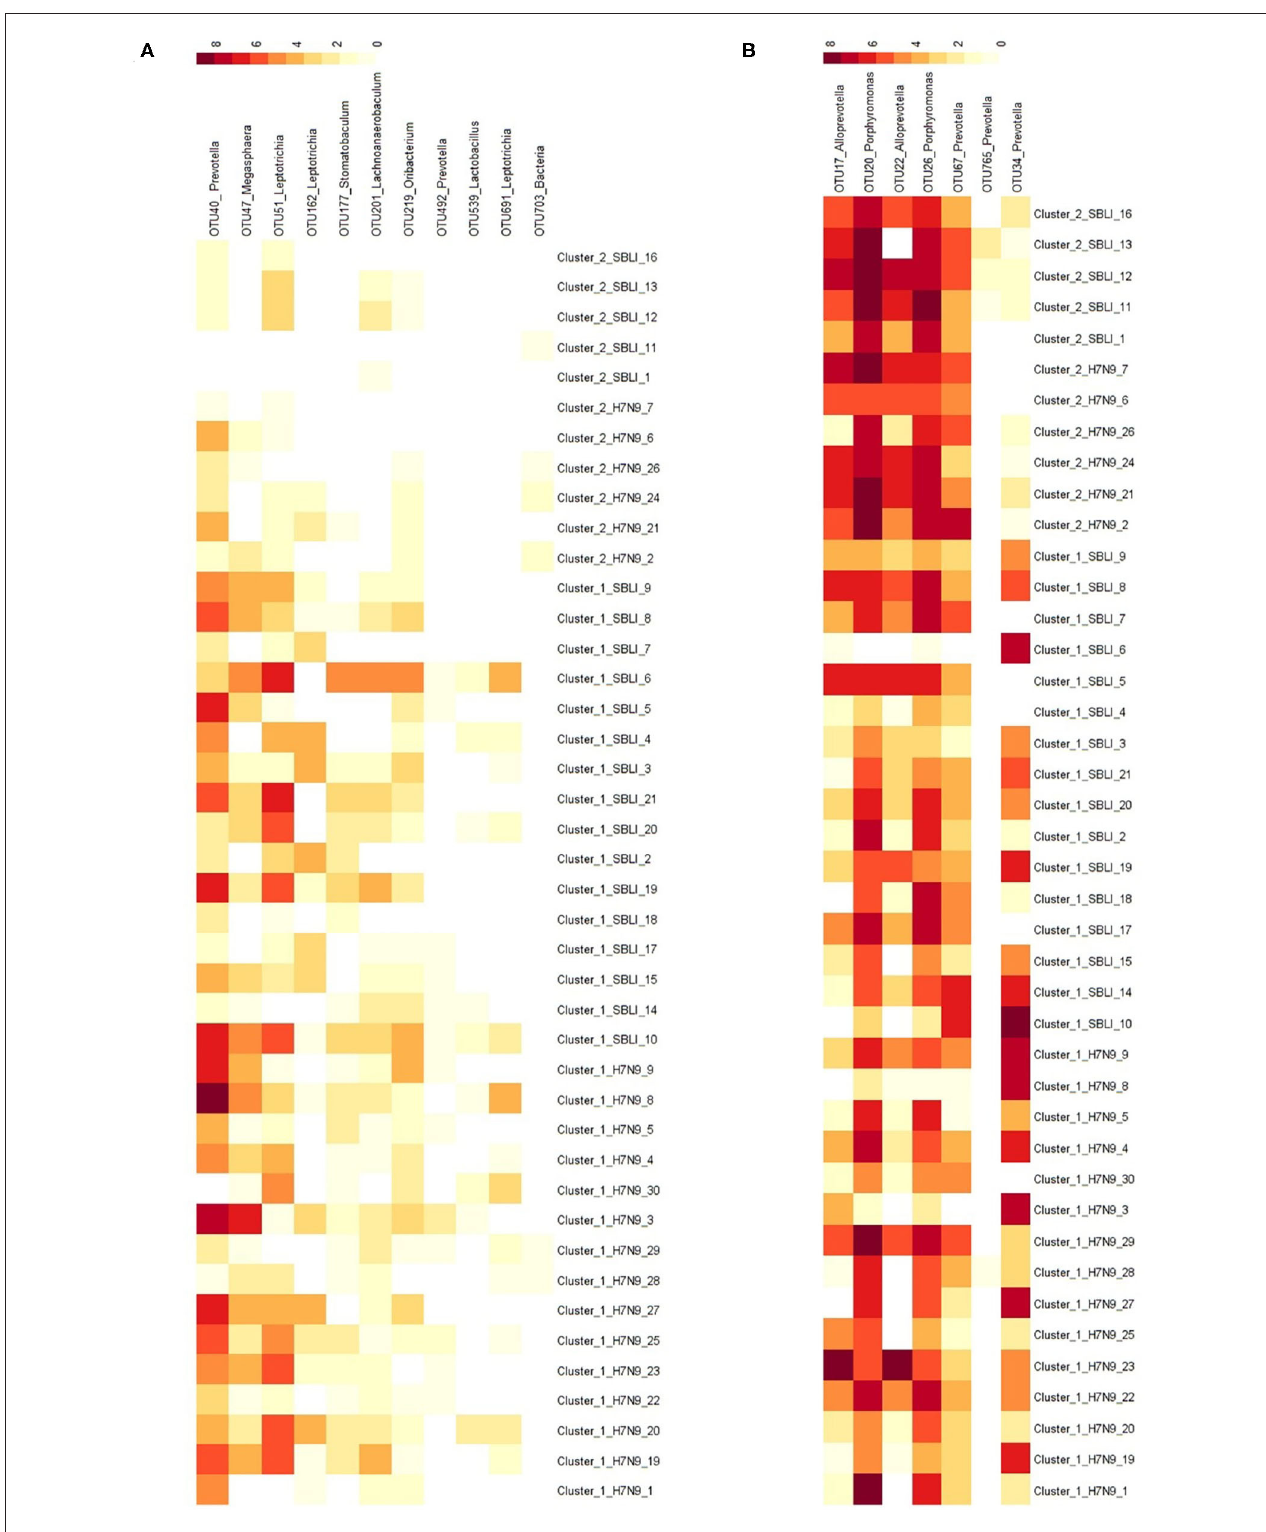
FIGURE 3 | Distributions of the OTUs associated with (A) H7N9 or (B) healthy cohort in the two clustered H7N9 patients. The demonstrated OTUs had significantly different abundances between the two clustered H7N9 patients.